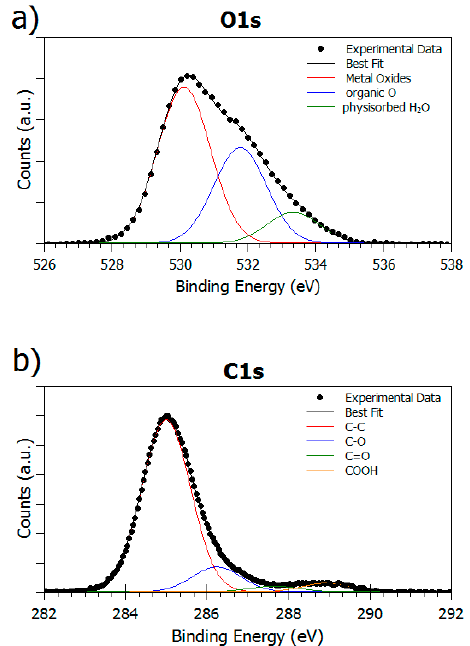
Figure 4. ( a ) XPS O1s and ( b ) XPS C1s spectra of the pristine sample